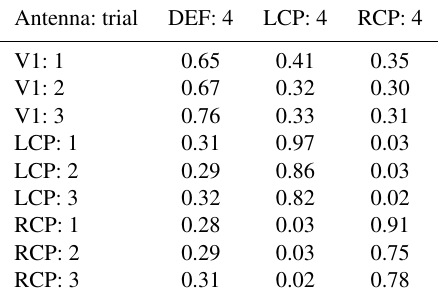
Table 12. Mean values of the power correlation coefficients over frequency for different antenna pairs. The Roman numerals indicate from which measurement trial the measured sample sequences of the specified antenna